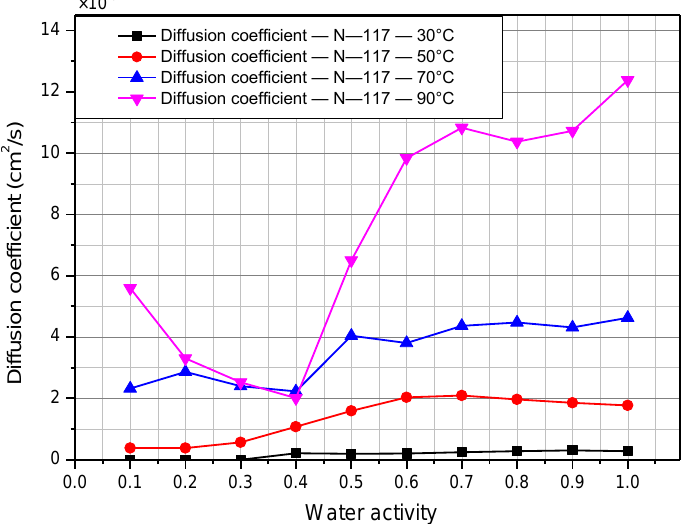
Figure 10. Diffusion coefficient of Nafion 117 membrane according to relative humidity at operating temperatures from 30 °C to 90 °C.